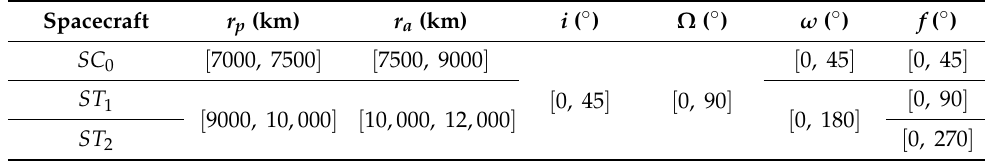
Table 3. Random initial orbital elements of the problem.